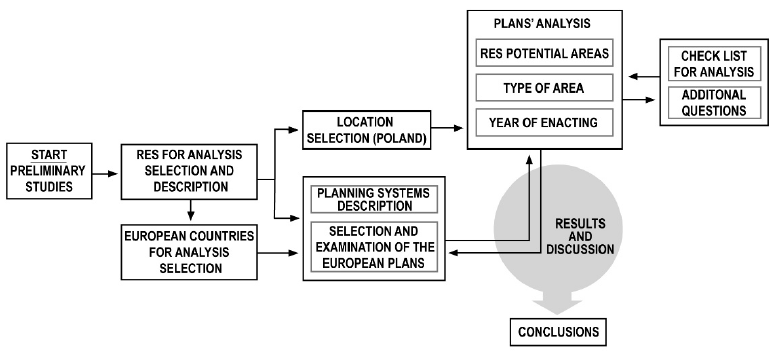
Figure 1. The overall research methodology.